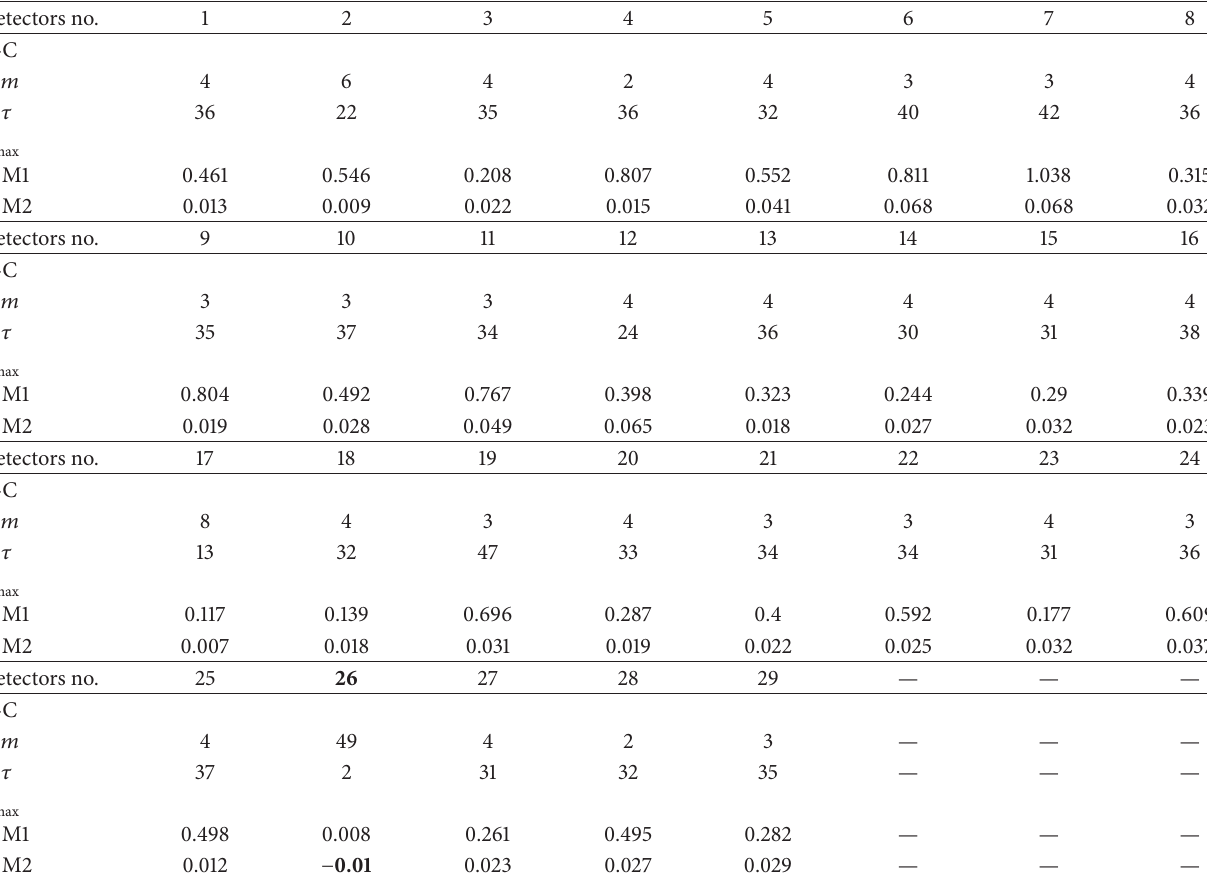
Table 3: C-C method result and Lyapunov exponents for flow.